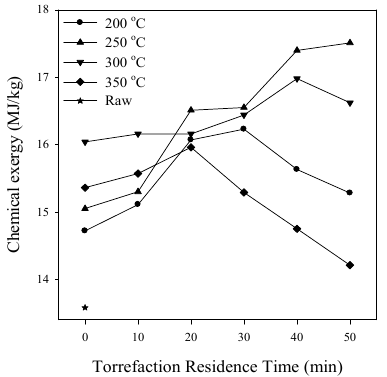
Figure 8. Chemical exergy of sewage sludge as a function of the torrefaction residence time.